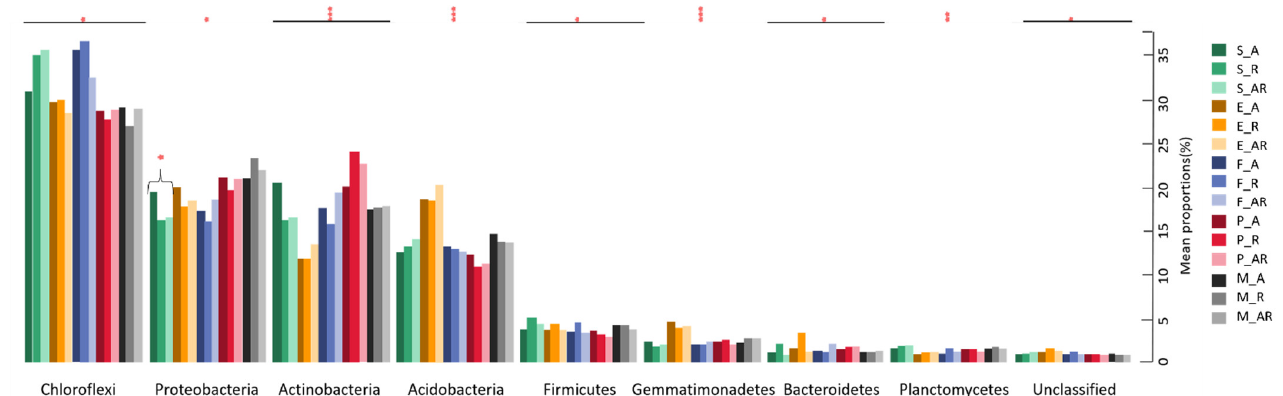
Figure 5. The differences between groups of microbial community abundance. S, E, F, P and M rep- resent seedling, stem elongation, flowering, podding and maturation stages, respectively; A, R and AR represent monoculture milk vetch, monoculture rapeseed, and milk vetch intercropping with rapeseed, respectively. * indicates p < 0.05, ** indicates p < 0.01, *** indicates p < 0.001.